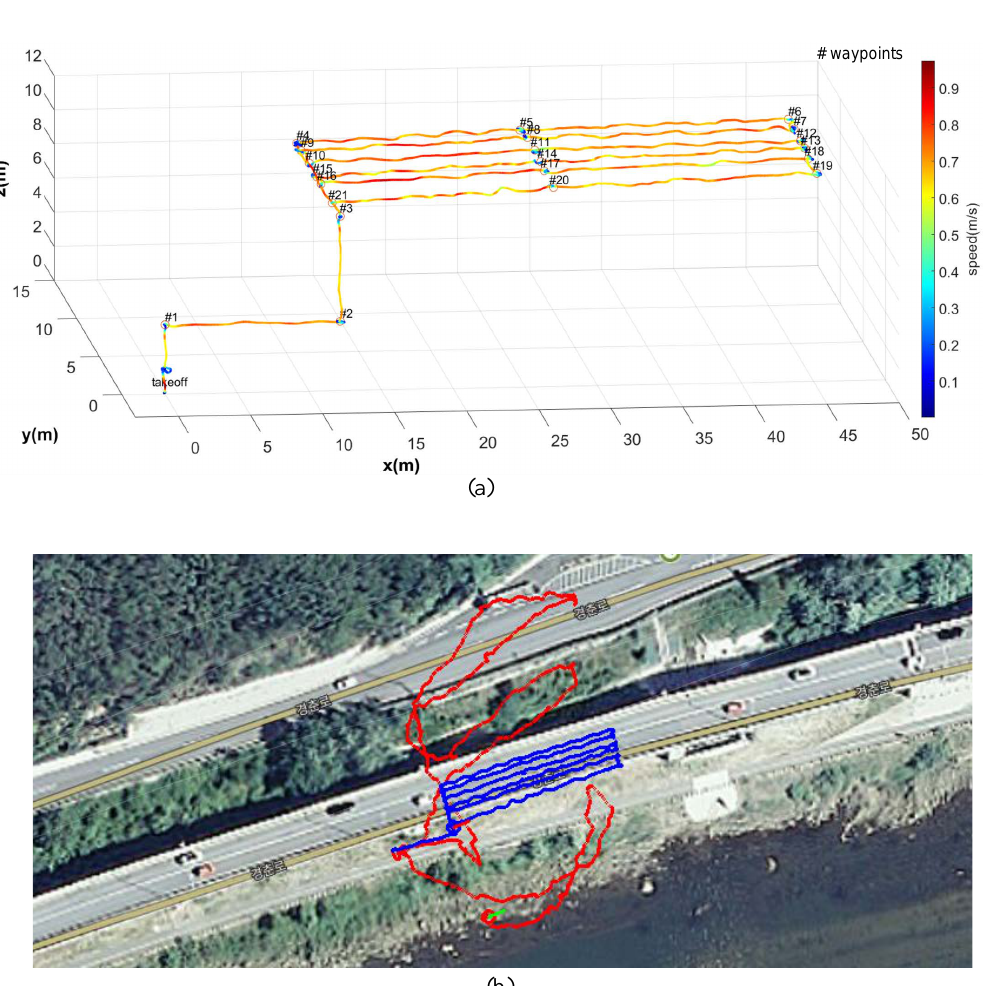
Figure 13. Field test of the overall framework at Deungseon Bridge. The system was used to obtain a 3D map of the target bridge, and the operator extracted waypoints by specifying the parts requiring inspection on the 3D map. Subsequently, using our proposed SLAM method and high-level control scheme, the UAV flew along the planned trajectory to obtain image data for the bridge. ( a ) Flight trajectory along the specified waypoints (from #1 to #21). The colors along the line represent the speed of the UAV. ( b ) Trajectory comparison: GPS (red line) vs. estimated (blue